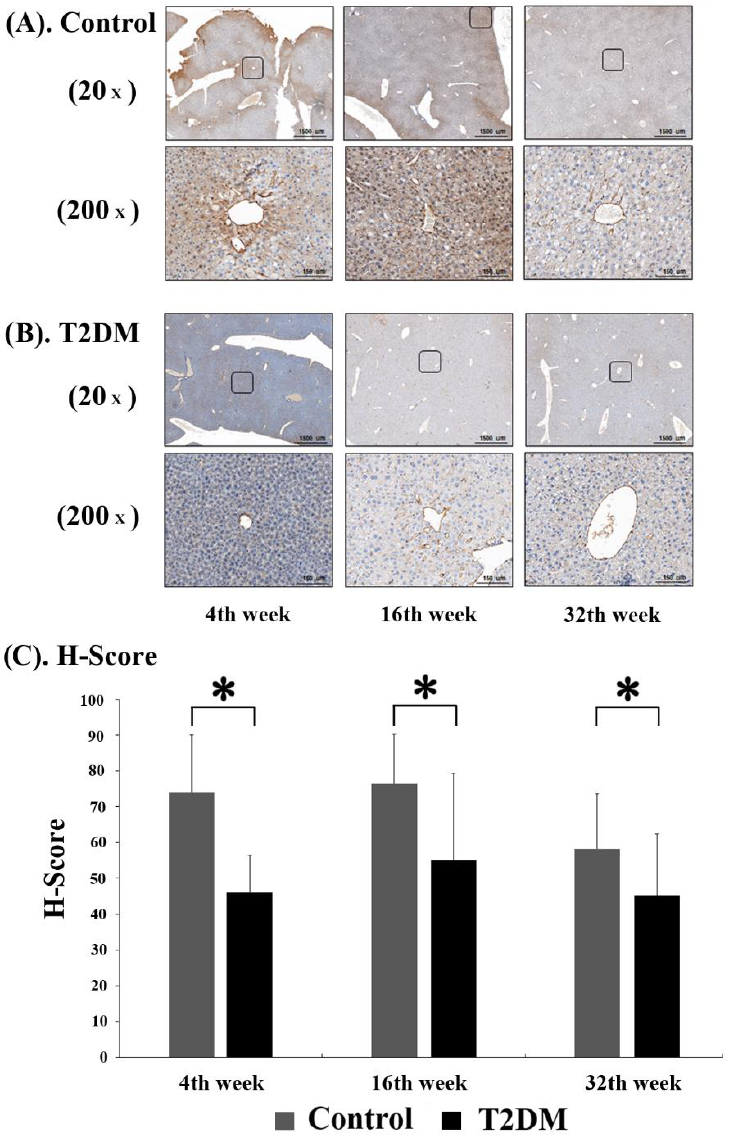
Figure 2. Immunohistochemistry (IHC) assay for Adiponectin (ADP) expression in control ( A ) and T2DM ( B ) mice was shown. The progression of mice model development for T2DM. Liver tissues were excised, fixed, paraffin-embedded, and sectioned for immunohistochemistry staining as described in Materials and Methods. Data are expressed as mean ± standard error of 3 independent experiments ( C ). * p < 0.05, for the comparisons indicated.